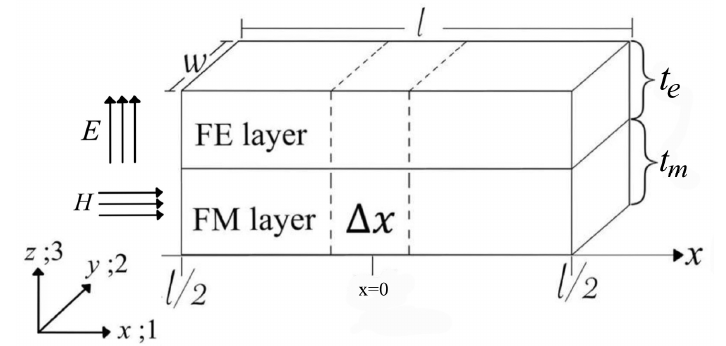
Figure 1. The tri–layer sensor structure consists of FE, FM, and AFM.